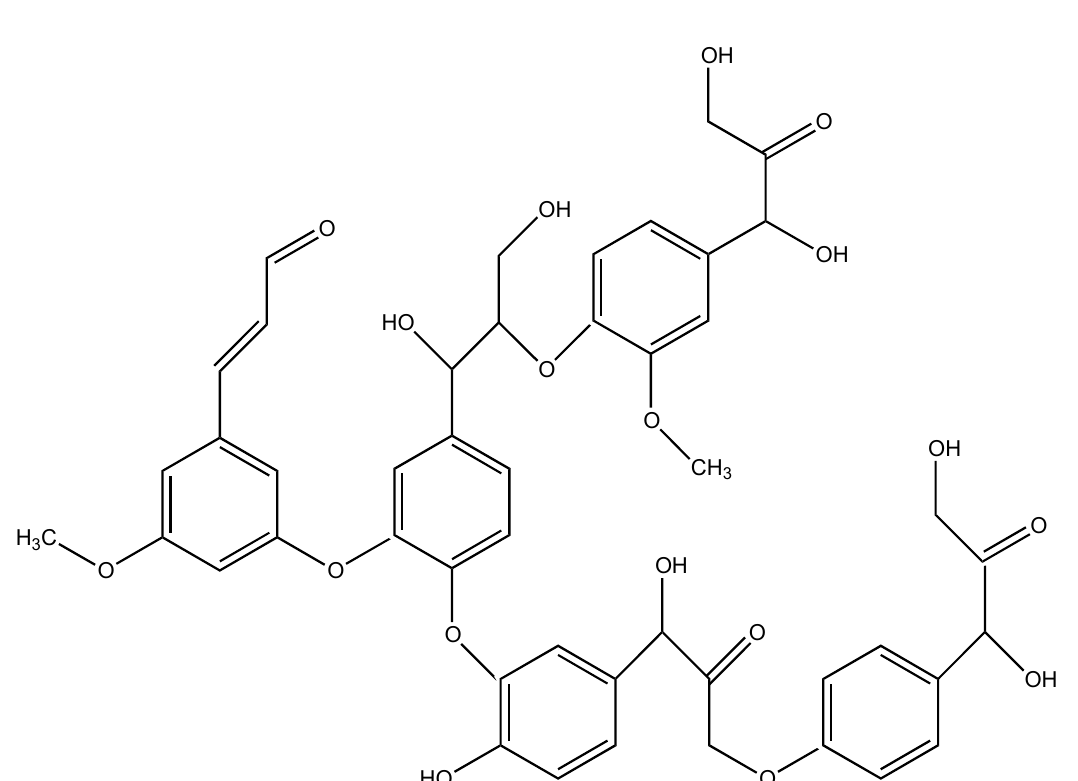
Figure 11. General structure of lignin.